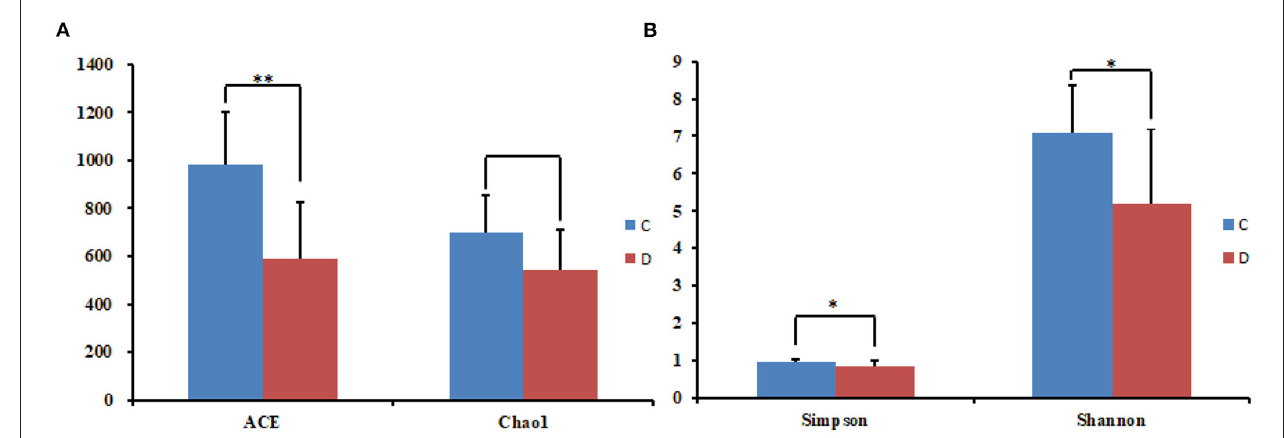
FIGURE 2 | Statistical results of the alpha diversity between the two groups. (A) ACE and Chao1 index; (B) Simpson and Shannon index. * p < 0.05, ** p < 0.01.